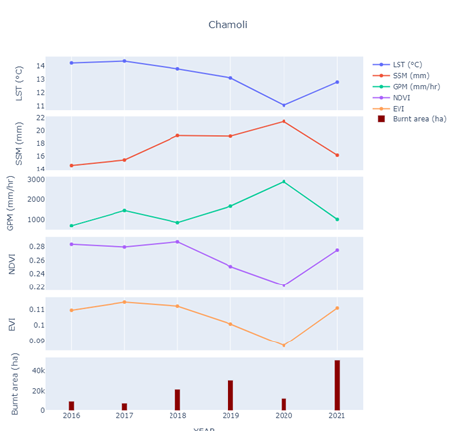
Figure 4. Spatio-temporal pattern of burnt area with the change in temperature, precipitation, NDVI, EVI and surface soil moisture for remaining nine districts of